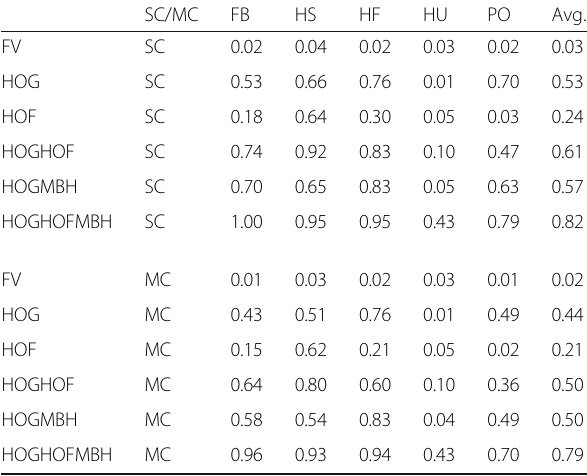
Table 1 Mean AuC using four-fold cross-validation on ShakeFive2 with σ = 0.3